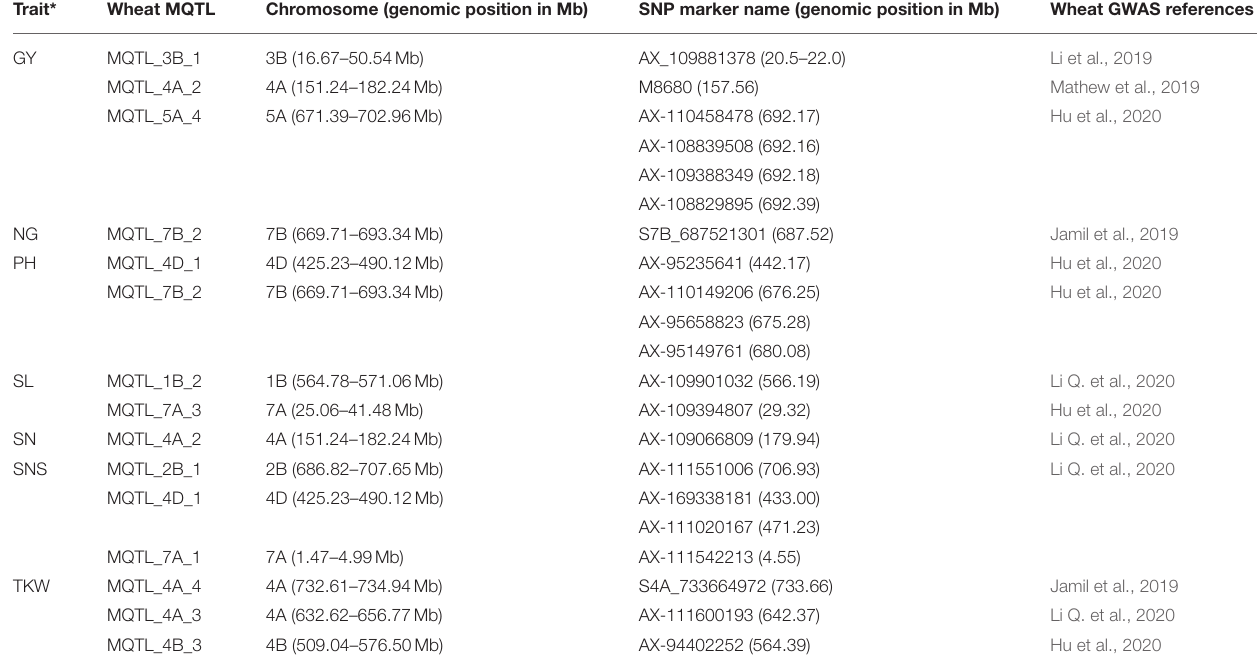
TABLE 4 | The collinear meta-quantitative trait loci (MQTLs) with the significant loci in wheat genome-wide association studies. Trait* Wheat